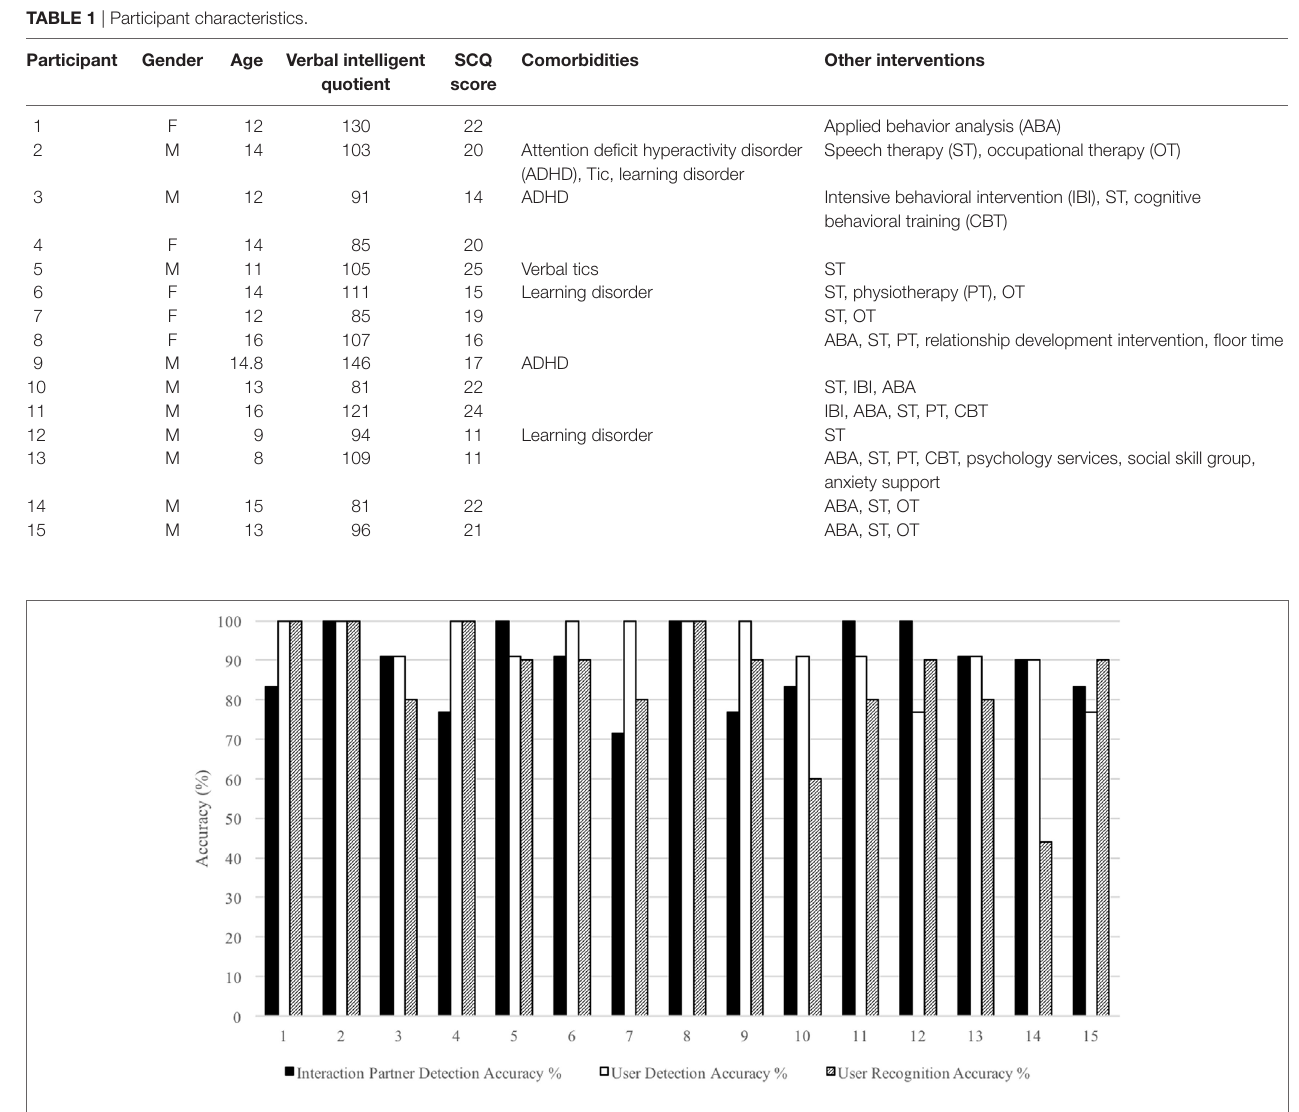
FigUre 6 | Detection and recognition accuracy across